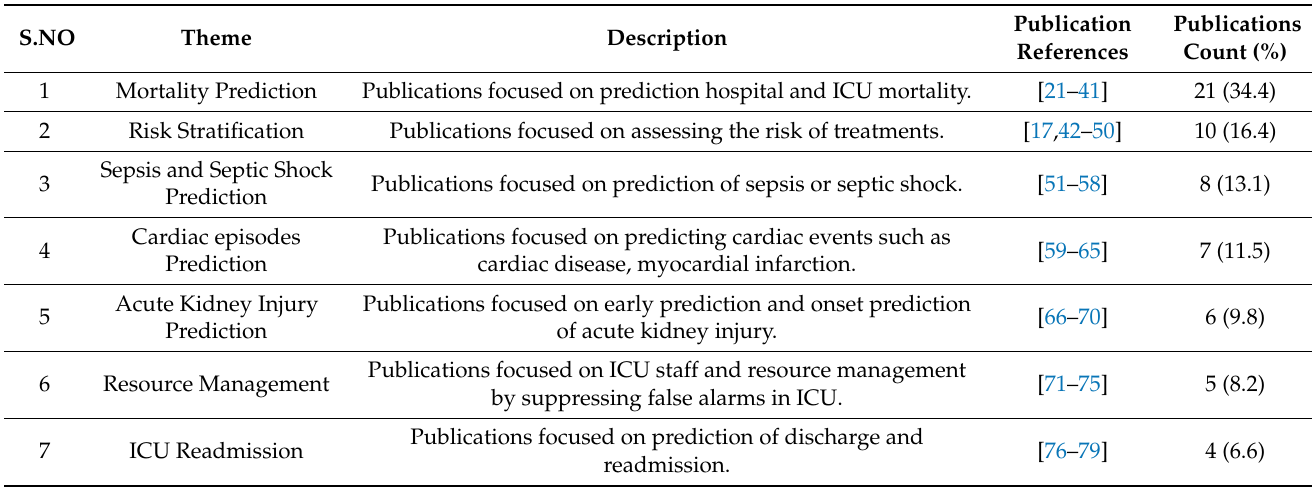
Table 1. An overview of the 61 publications in the literature, classified into seven themes and their descriptions. The themes are listed according to the frequency of publication (percentage and absolute